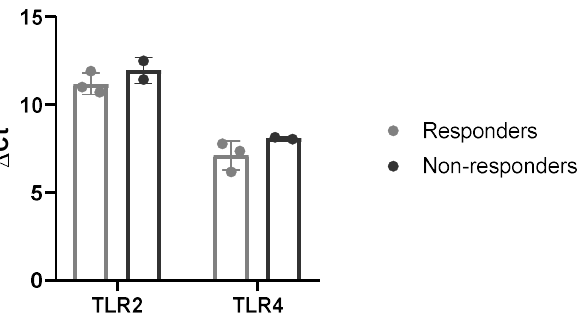
Figure 3. Basal expression levels of TLR2 and TLR4 in responders (grey, n = 3) and non-responders (black, n = 2). Data represents mean with SD.